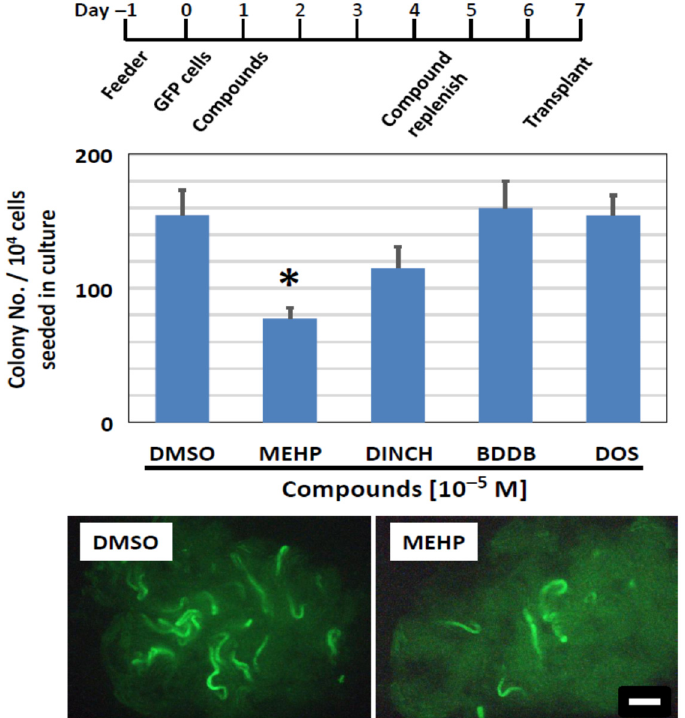
Figure 9. Colonization ability of SSCs exposed to plasticizing compounds, measured using spermatogonial transplantation. ( Top ) Schedule of compound exposure. It followed the 6-day exposure protocol as shown in Figure 7. ( Middle ) Results of the transplantation assay. Newly synthesized compounds, BDDB and DOS, did not affect the colonization ability of SSCs, as the number of spermatogenic colonies established after transplantation is comparable to that of control (DMSO). Although DINCH shows a trend of a reduced colony number, the difference was not significant. MEHP significantly reduces the colony number (Asterisk). ( Bottom ) Photomicrographs of recipient testes transplanted with GFP cluster cells, including SSCs, that were exposed to DMSO or MEHP. Green stretches of seminiferous tubules indicate the colony of spermatogenesis derived from cultured SSCs. Scale bar = 1